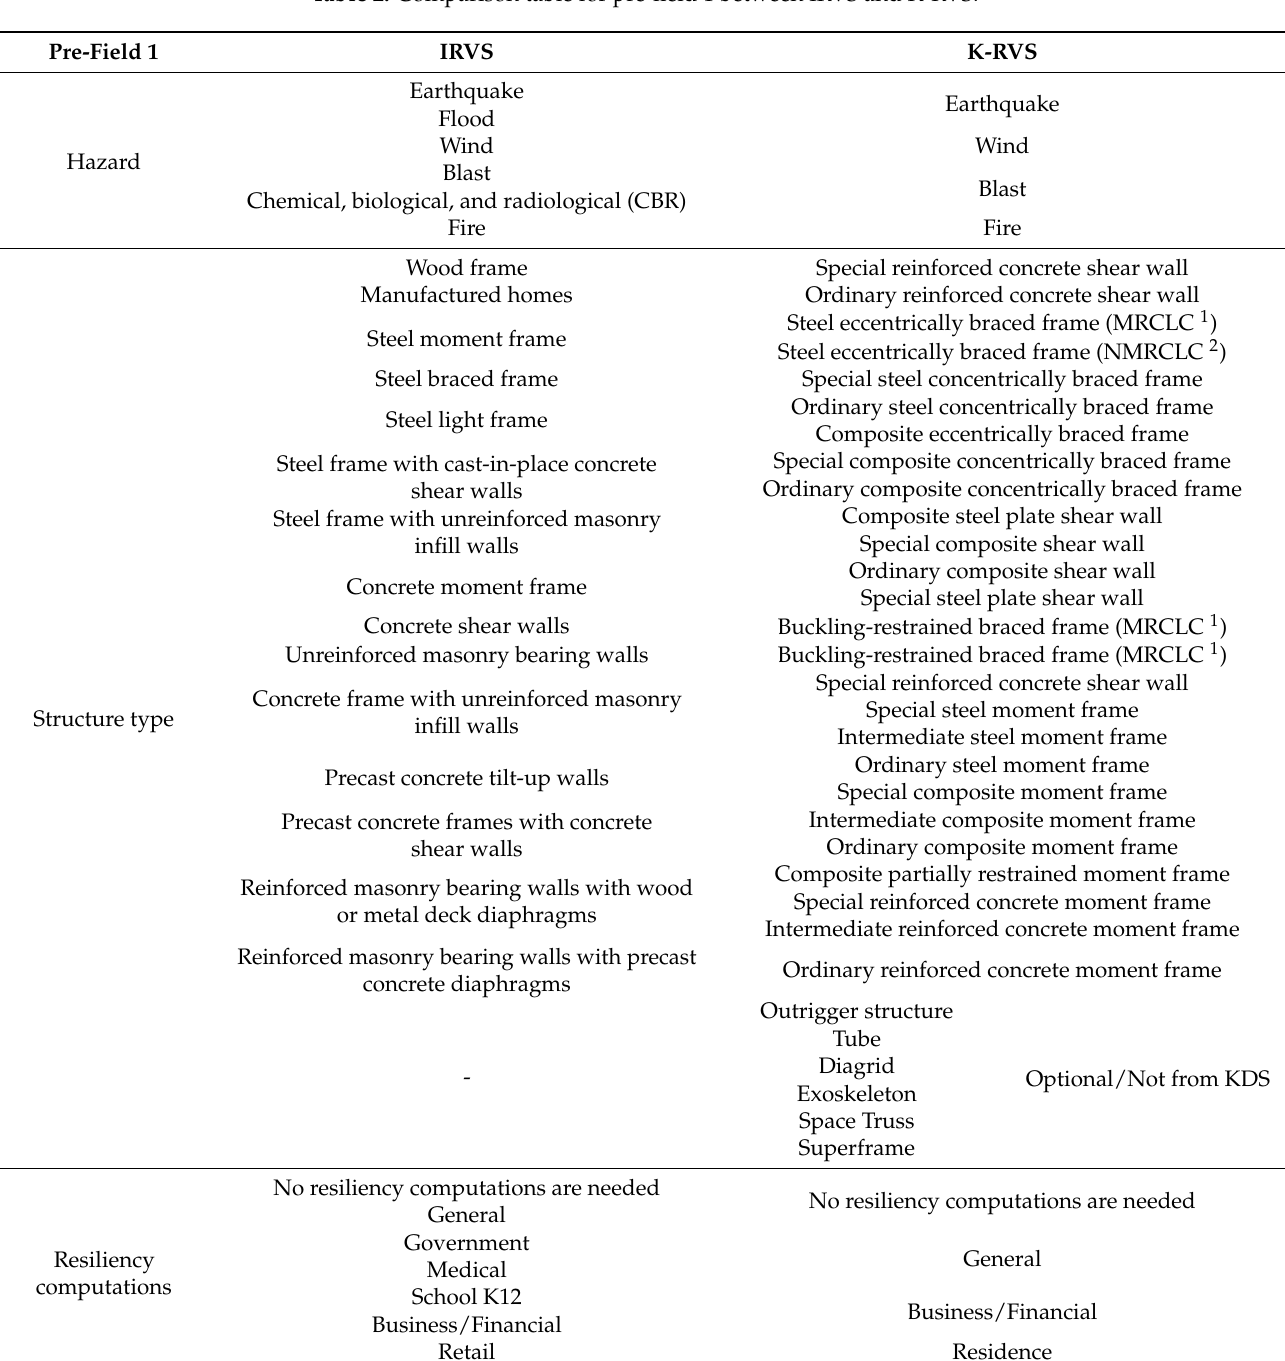
Table 2. Comparison table for pre-field 1 between IRVS and